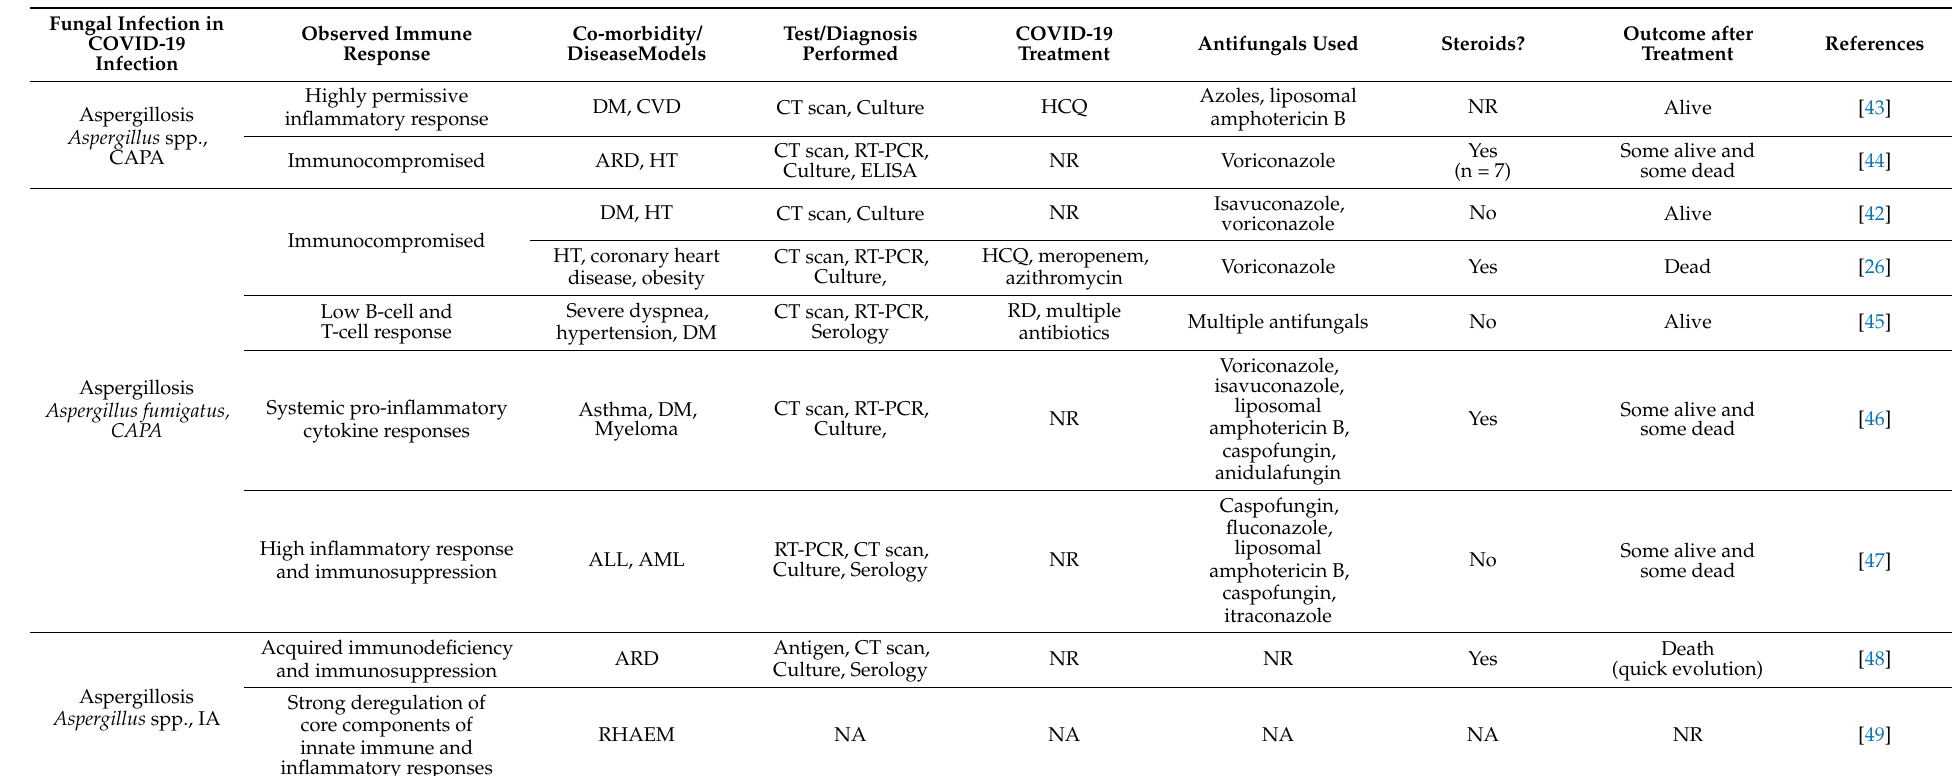
Table 2. Clinical characteristics of COVID-19 patients reported with